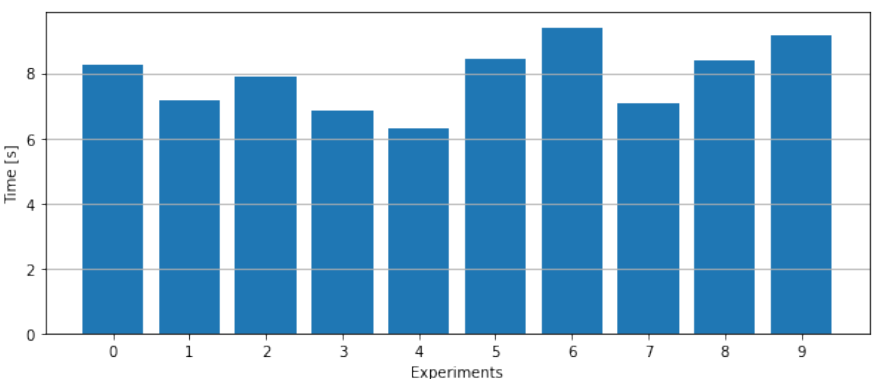
Figure 7. Computational times of the DEH on the